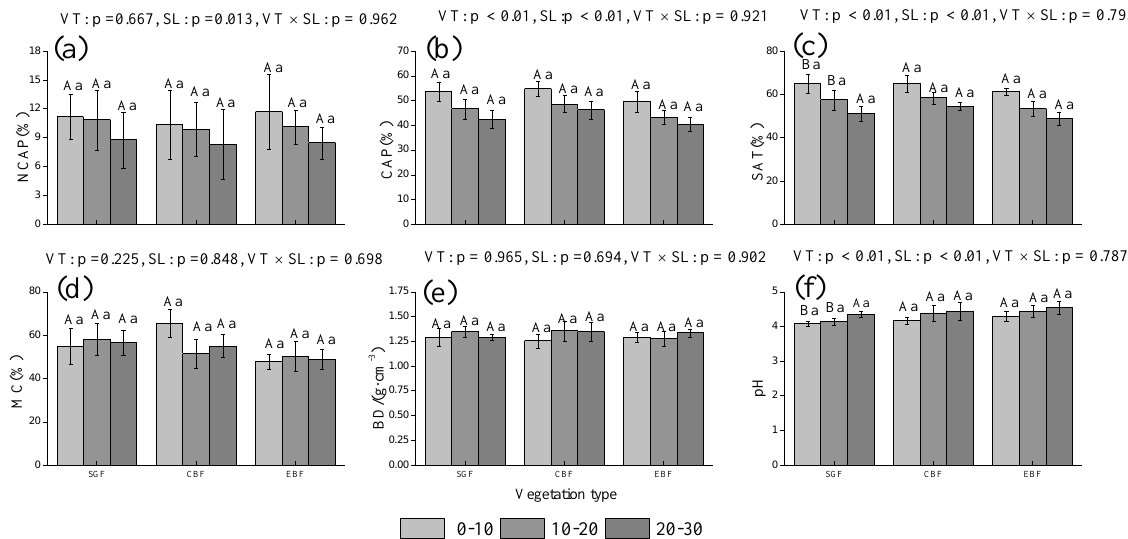
Figure 1. Soil water-physical properties of three vegetation types and three soil layers (mean ± SE, n = 4). SE is the variance of the index. The error line indicates standard error; upper case letters indicate a significant difference among different soil layers of the same land use types ( p < 0.05); the lower case letter indicates a significant difference between different land use types of the same soil layer ( p < 0.05). EBF stands for evergreen broad-leaved forest; CBF stands for mixed forest; SGF stands for shrub-grass forest; NCAP stands for non-capillary porosity; CAP stands for capillary porosity; SAT stands for total porosity; BD stands for bulk density; MC stands for moisture content; VT stands for vegetation type; SL stands for soil layer. Two-way ANOVA was applied to indicate significant differences between variances. ( a ) shows the NCAP in different soil layers in different stands; ( b ) shows the CAP in different soil layers in different stands; ( c ) shows the SAT in different soil layers in different stands; ( d ) shows the MC in different soil layers in different stands; ( e ) shows the BD in different soil layers in different stands; ( f ) shows the pH in different soil layers in different